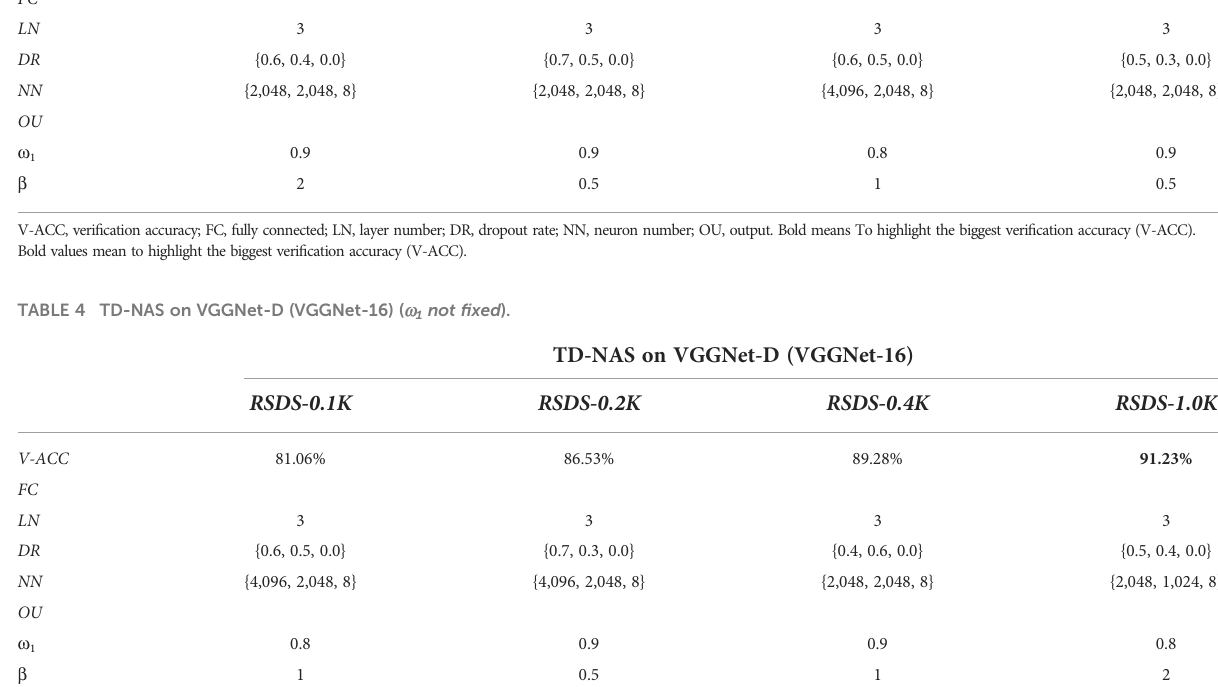
Figure5showsfourconfusionmatrixesgeneratedoneachtestset